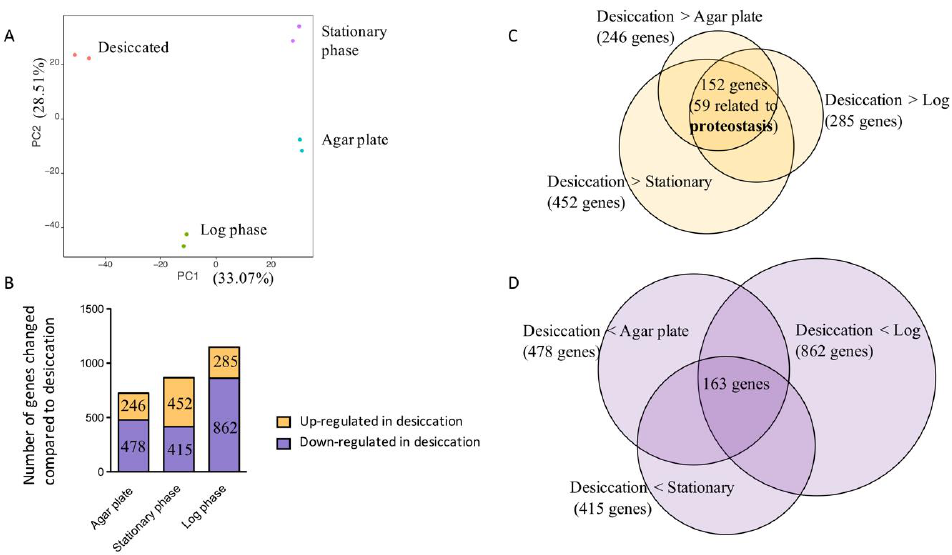
Figure 2. Transcriptomic analysis of desiccated and growing bacteria. ( A ) PCA analysis of the 17978 transcriptomes after desiccation, or after growing in liquid LB to stationary phase or log phase or on an LB agar plate. K-means clustering at n = 4 with Pearson distance was performed on the 8 samples. Samples from each condition clustered together as shown by colors of the dots. Desiccated samples and growth samples were all separated. ( B ) The number of genes significantly changed in expression level after desiccation compared to each growth phase at a cutoff of p < 0.01. In each comparison, the purple column represents the number of genes down-regulated in desiccation, whereas the yellow one represents the up-regulated genes. ( C ) The overlaps of upregulated genes in desiccation among the three comparisons. ( D ) The overlaps of down-regulated genes in desiccation among the three comparisons.